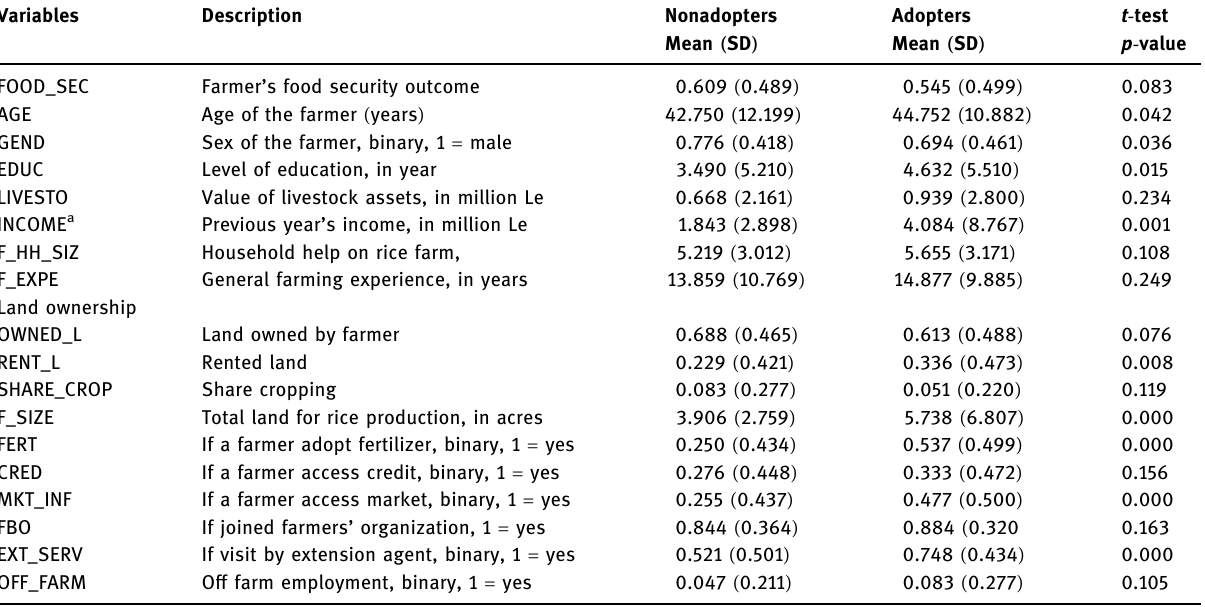
Table 2: Descriptive statistics of variables employed in the analysis